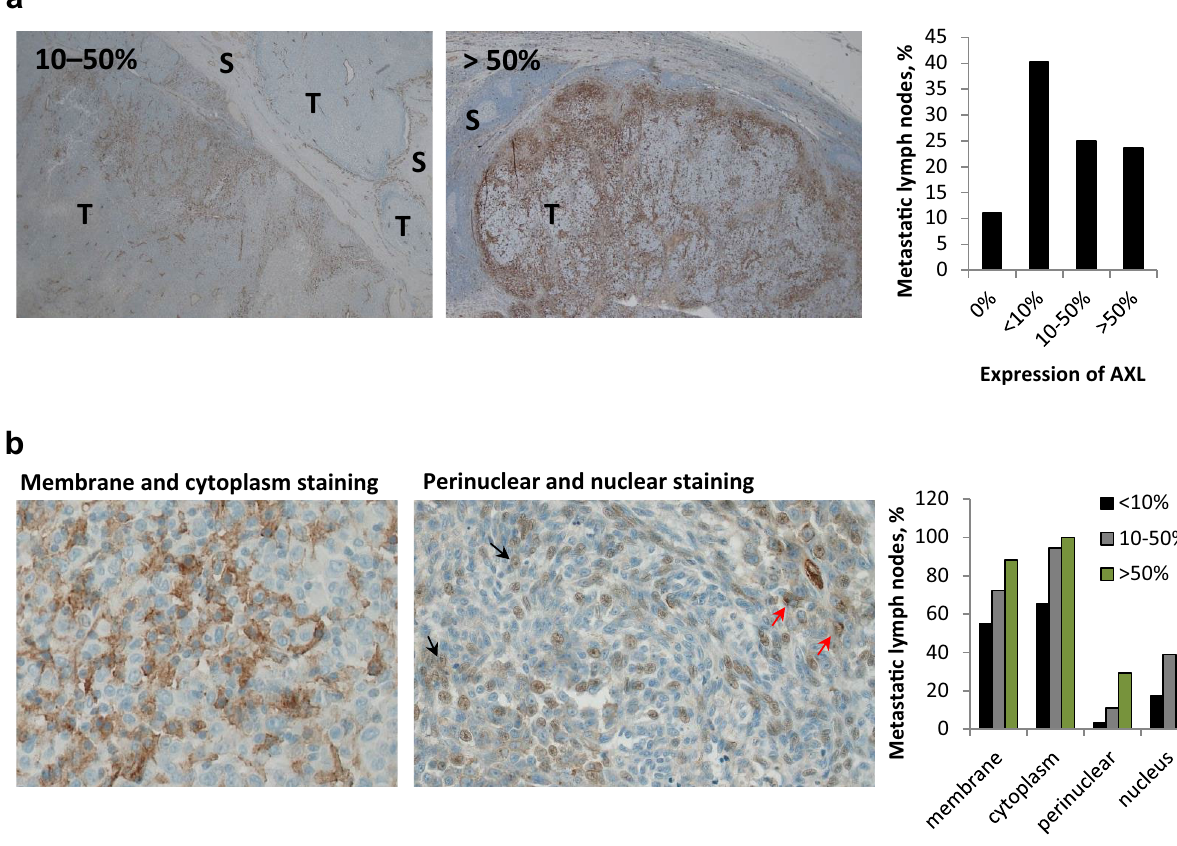
Figure 1. AXL expression and localization in melanoma lymph node metastases. AXL expression levels in 72 samples of metastatic lymph nodes were evaluated and depending on the expression status assigned into four sub-groups: no expression (0%), lower than 10%, 10–50% and more than 50%. ( a ) Representative IHC stainings of AXL expression level and localization are presented. Bar graph indicates the % of samples within each sub- group, where a total sample number was set to 100%. ( b ) Representative IHC staining of AXL within tumor cells, showing membrane and cytoplasm staining (left), and perinuclear and nuclear staining, indicated with red and black arrows, respectively (right). Bar graph indicates the % of AXL positive samples in the indicated cellular compartments within the different scoring sub-groups presented in ( a ). The total number within each sub-group exceeds 100% since samples may be positive in multiple cellular compartments. T, tumor region; S, stromal region. Images were taken at ×100 ( a ) or 200x ( b )